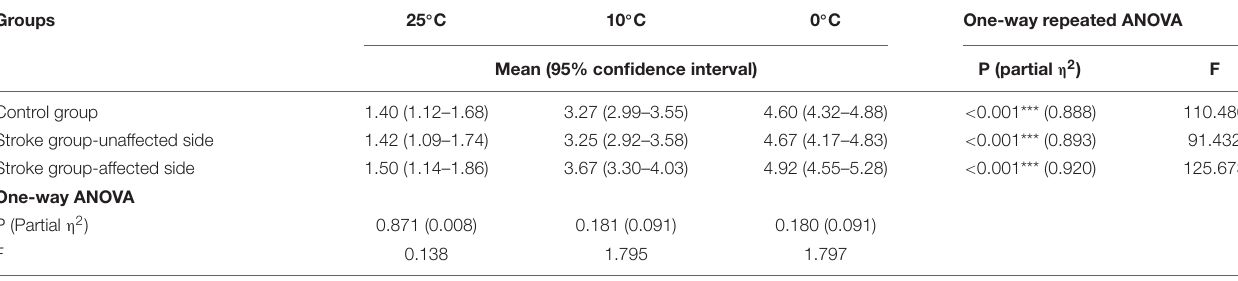
TABLE 5 | Non-painful cold sensation evaluated by visual analog